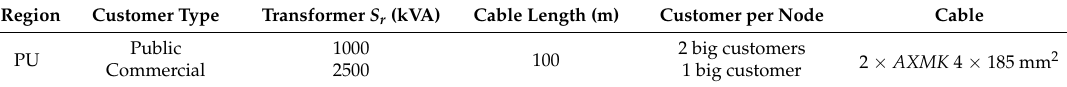
Table 3. LV grid component parameters for public and commercial customers in urban areas. Table 4. Test network parameters and their limiting constraints for domestic customers.